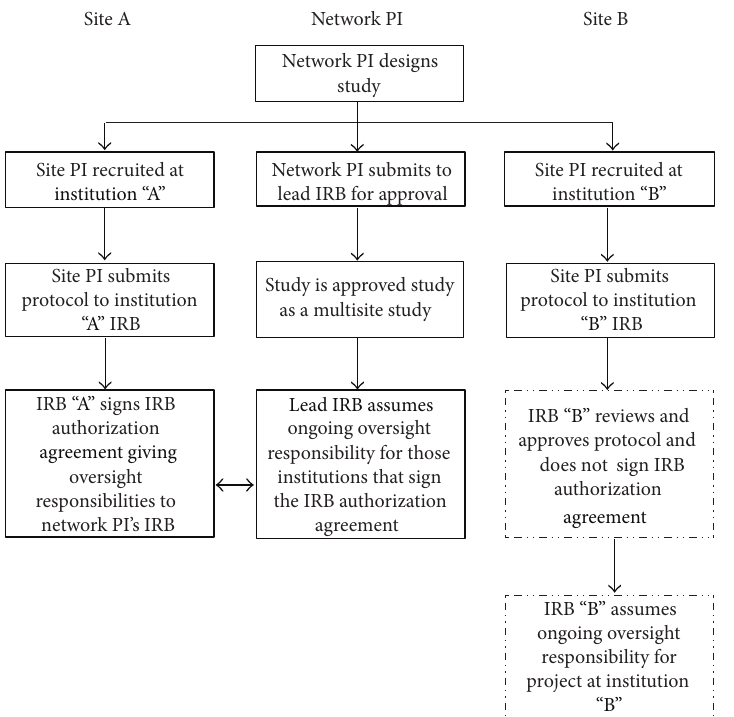
Figure 1: Overview of the multi-site research approval